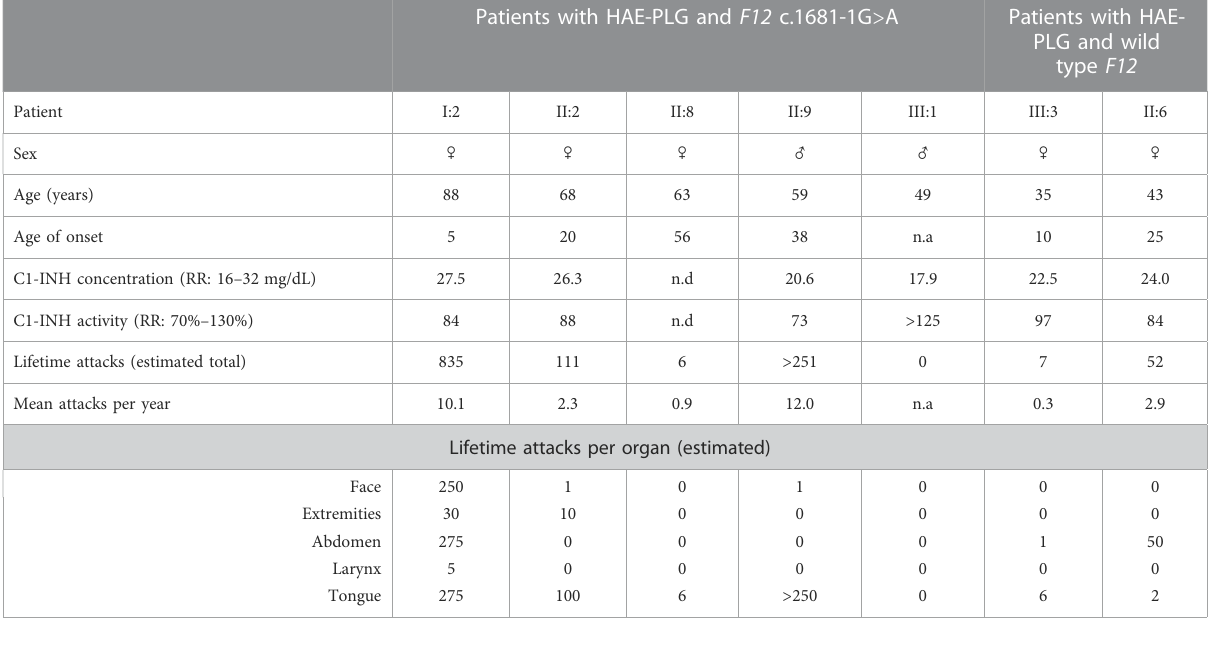
TABLE 1 Clinical data of affected individuals of the large family with HAE-PLG comparing individuals with and without additional F12 mutation c.1681-1G > A. (n.a. not available; n.d. not determined). Patients with HAE-PLG and F12 c.1681-1G > A Patients with HAE-